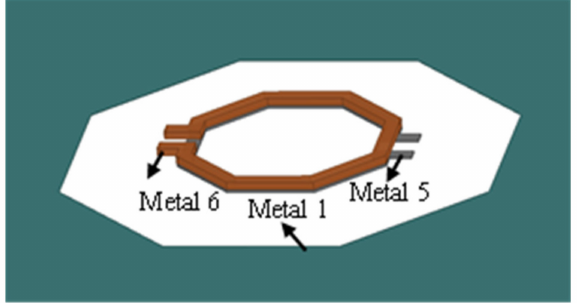
Figure 2. Geometry of the proposed transformer.